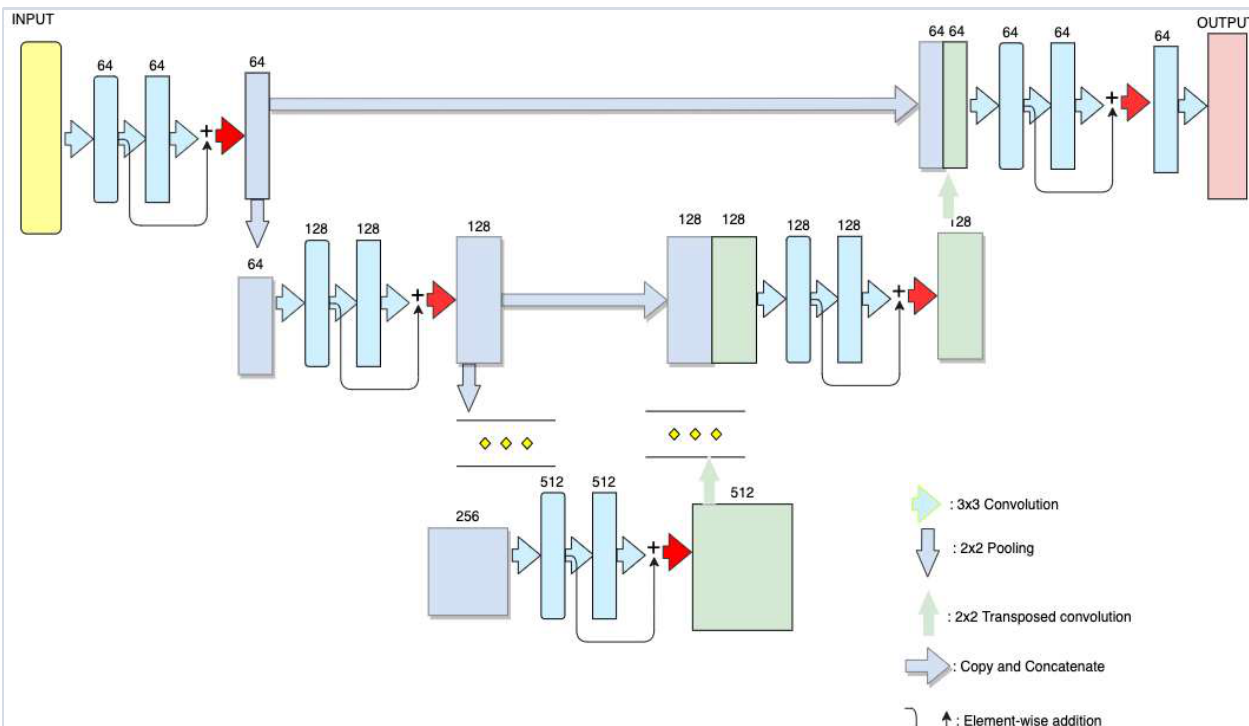
Figure 2. Modified UNet with a ResNet-50 encoder.